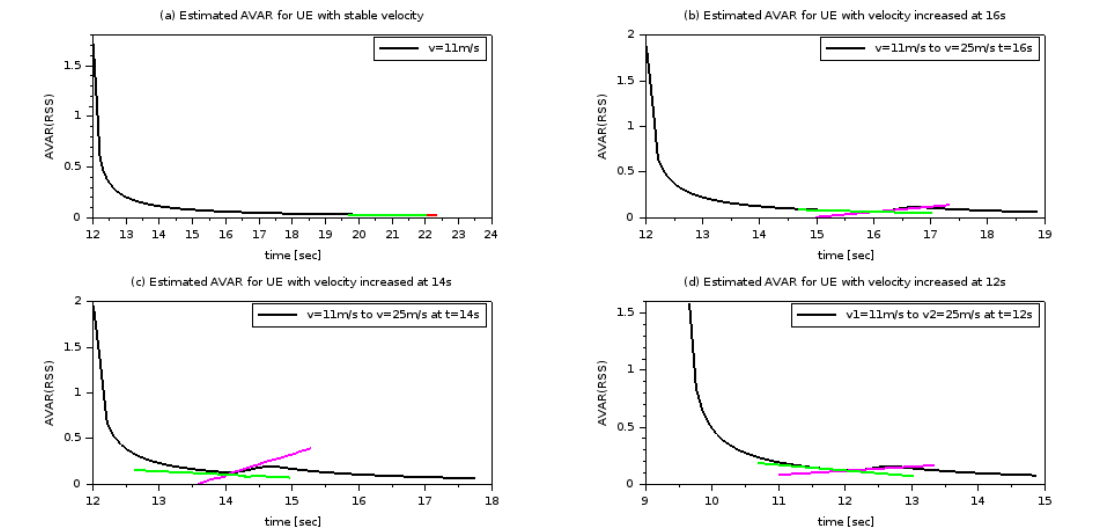
Figure 2. The Allan variance (AVAR) of the received signal strength (RSS) for the user equipment (UE) leaving the access point (AP) area.